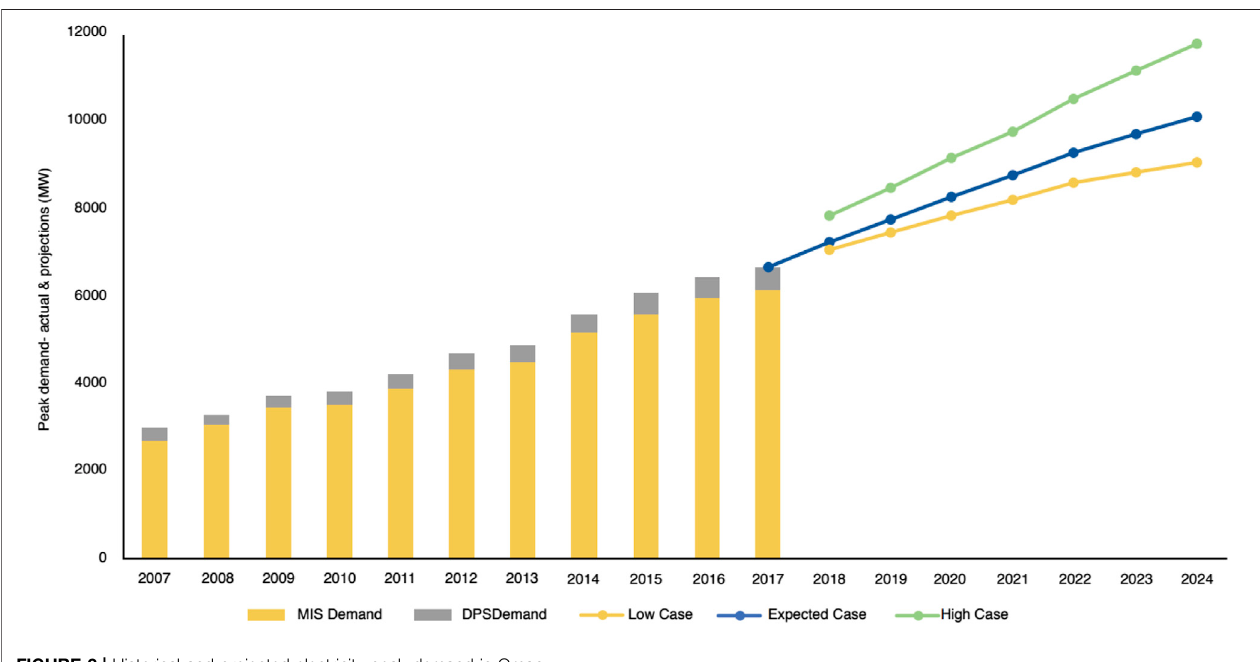
FIGURE 2 | Historical and projected electricity peak demand in Oman.